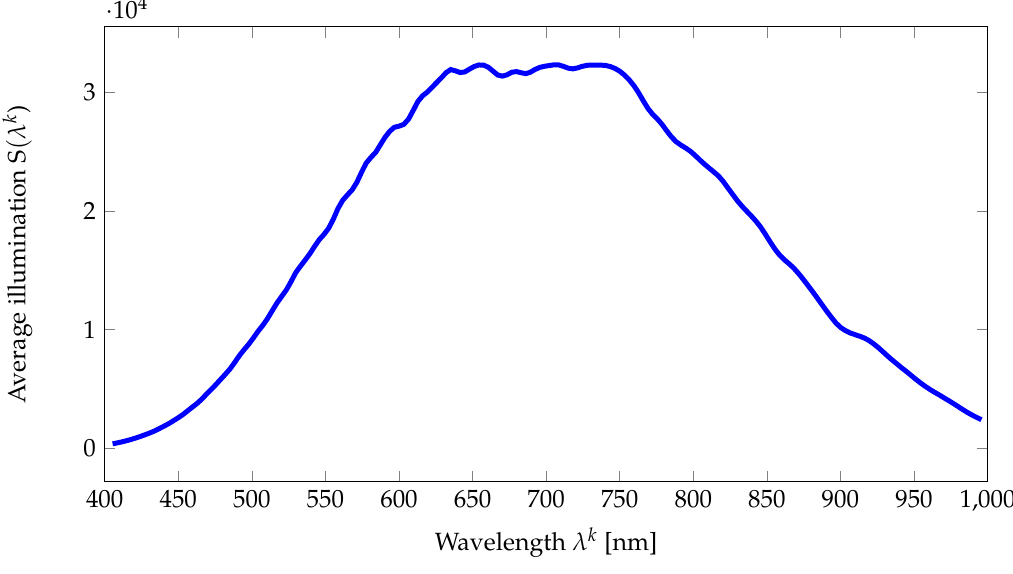
Figure 7. Average illumination computed over the 112 radiance images.